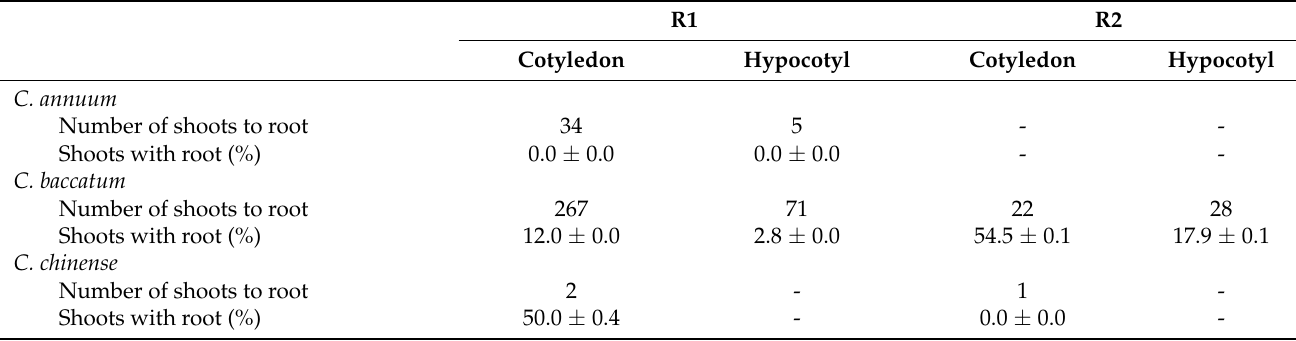
Table 9. Rooting of shoots of C. annuum , C. baccatum and C. chinense in R1 medium (0.5 mg/L of IBA) and in R2 medium (1 mg/L of IBA). The data represent the number of cotyledon and hypocotyl explants transferred and percentage of rooted explants ± standard